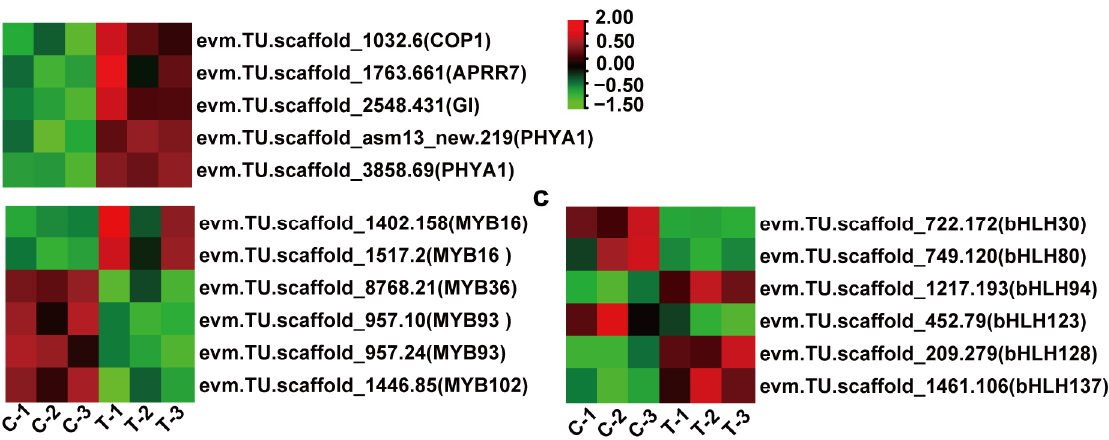
Figure 5. Heat map of differentially expressed genes (DEGs) related to the circadian clock ( a ), MYB TFs ( b ), and bHLH TFs ( c ) between control (water) and ethephon-treated samples. C-1, C-2, and C-3 represent three control samples. T-1, T-2, and T-3 represent three ethephon-treated samples.